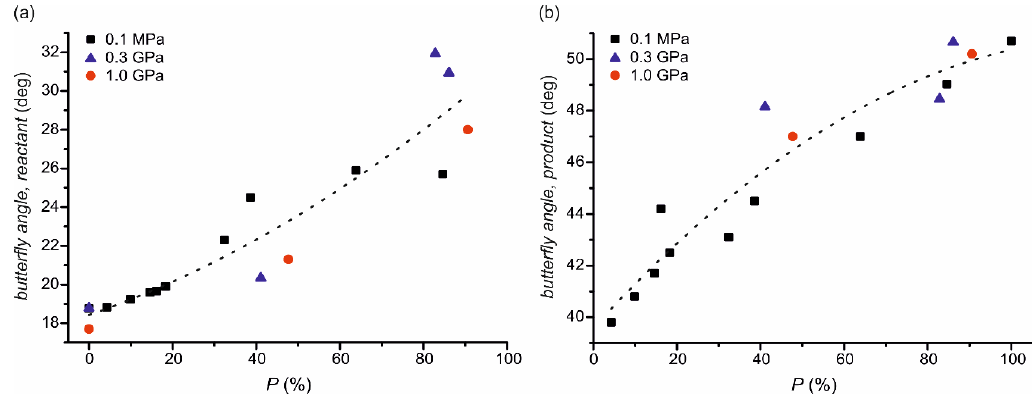
Figure 4. Changes in the “butterfly” angle for ( a ) the reactant and ( b ) the product molecule along with the reaction progress. The values for 0.1 MPa were calculated on the ground of the data taken from [5]. Standard uncertainties are in ranges 0.07–0.9°, 0.5–3° and 0.5–4° for 0.1 MPa, 0.3 GPa and 1.0 GPa, respectively.